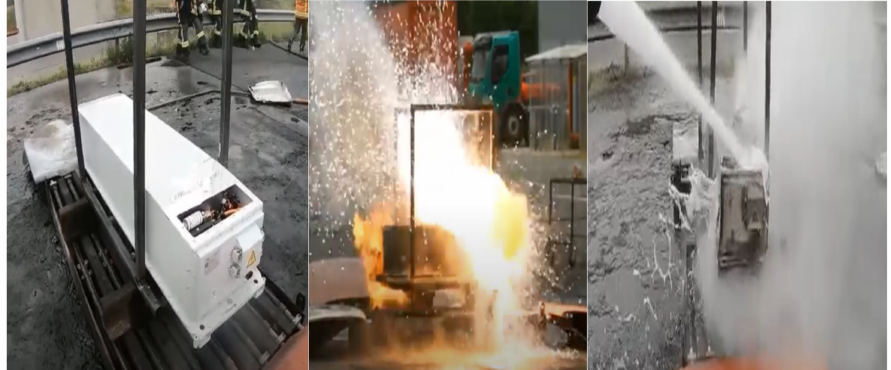
Figure 20. Exp. A.6